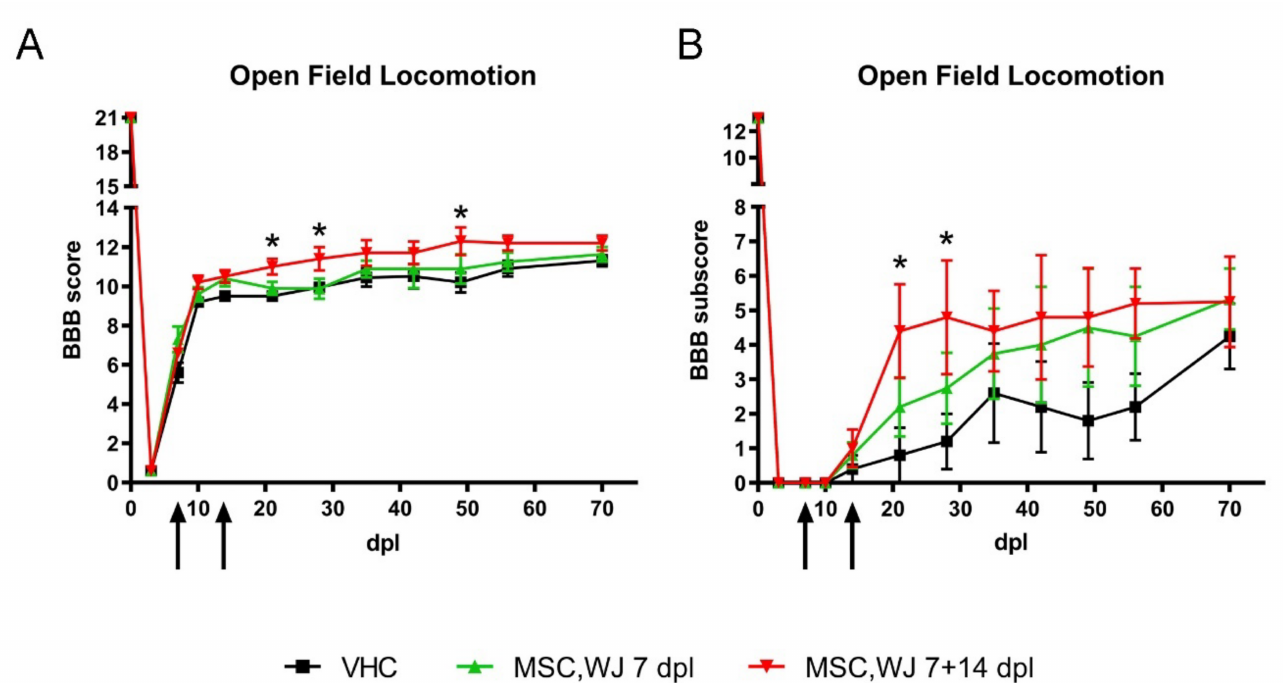
Figure 3. Effects of MSC,WJ administration on functional recovery. Open-field locomotion was evaluated weekly after spinal cord injury (SCI) using the score ( A ) and subscore ( B ) of the Basso, Beattie, Bresnahan (BBB) scale in the three studied groups (each group n = 5): vehicle or VHC (group of animals with SCI and vehicle administered intrathecally at 7 days post-lesion, or dpl), MSC,WJ 7 dpl (group of animals with SCI and 1 × 10 6 MSC,WJ cells intrathecally at 7 dpl, arrows) and MSC,WJ 7 + 14 dpl (group of animals with SCI and 1 × 10 6 MSC,WJ cells intrathecally at 7 and 14 dpl, arrows). All animals showed a temporal paralysis (BBB score of 0) just after the injury with partial recovery until day 14 and a plateau phase until the end of follow-up. * p < 0.05 group MSC,WJ 7 + 14 vs. VHC.